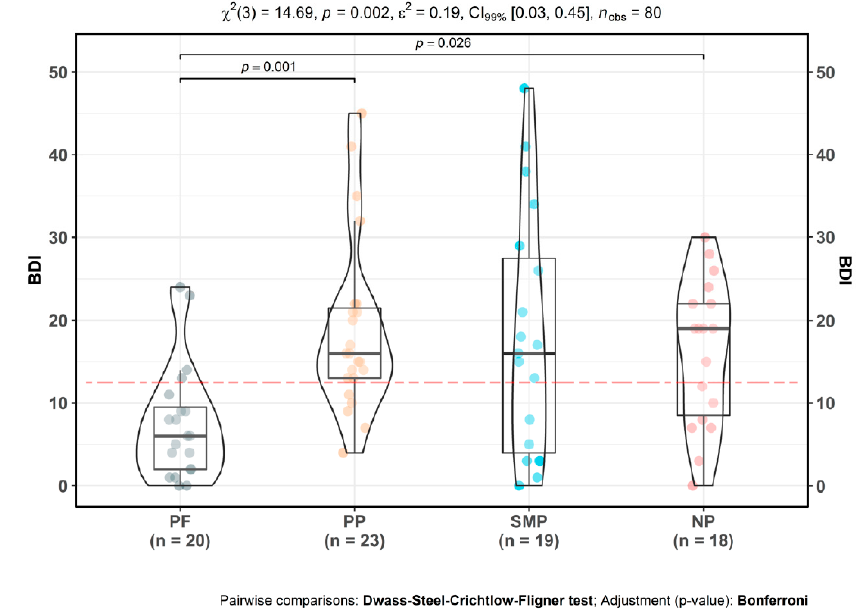
Figure 3. Depressive symptoms in CP. PF: pain-free participants. PP: primary CP participants, SMP: secondary musculoskeletal CP participants, NP: neuropathic CP participants. Mean values: PF µ = 7.5, CI 95% (4.29, 10.71), PP µ = 18.83, CI 95% (14.31, 23.35), SMP µ = 17.84, CI 95% (10.77, 24.91), NP µ = 16.11, CI 95% (11.73, 20.49). Red dotted line indicates clinical cut off for depressive symptoms, scores above 14 differentiate mild, moderate and severe depressive states [65,66]).